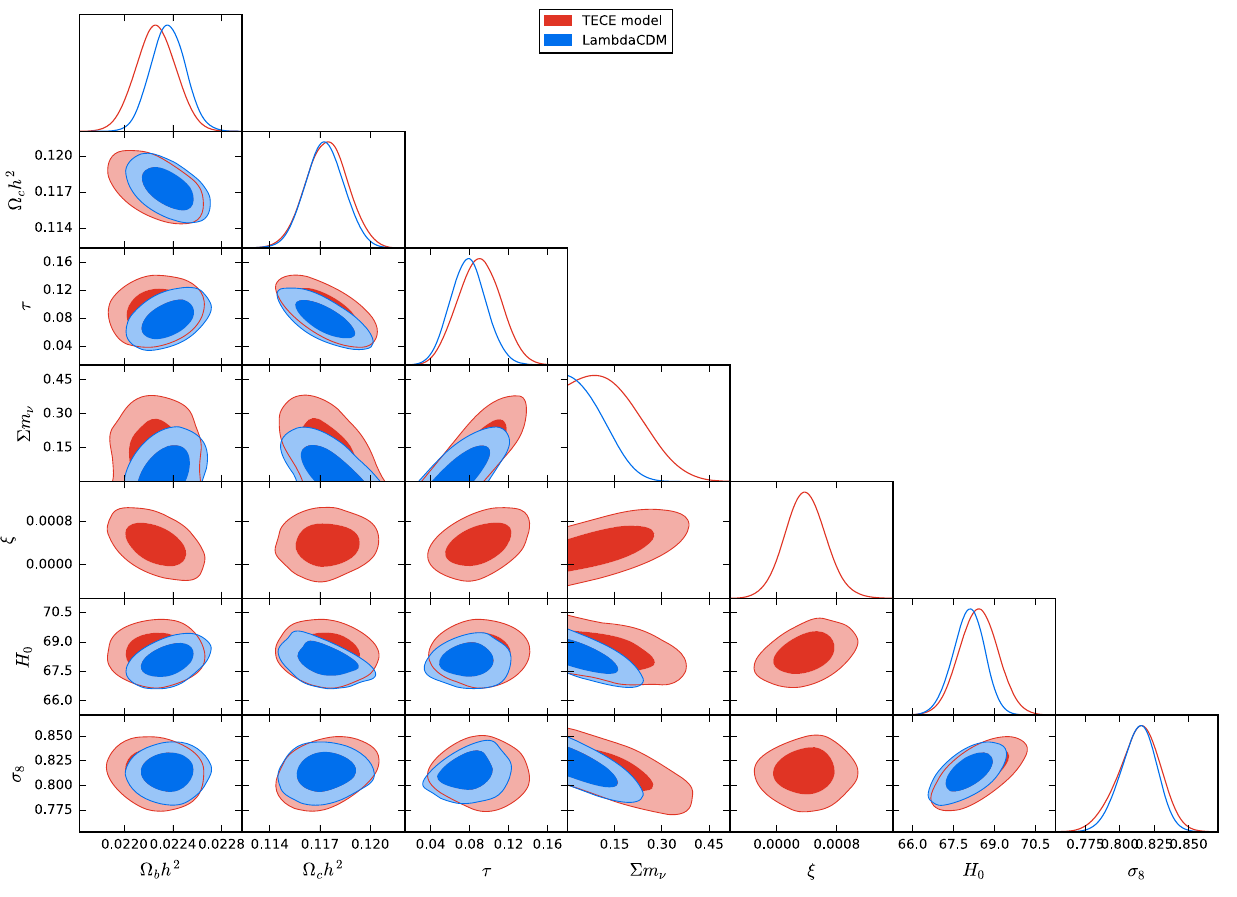
Fig. 12 Legend is the same as Fig. 11 but for the TECE and (cid:2) CDM models Table 4 Fitting results for the TECE and (cid:2) CDM models, where the limits are given at 68% and 95% C.L., respectively Parameter TECE (68% C.L.) TECE (95% C.L.) (cid:2) CDM (68% C.L.) (cid:2) CDM (95%